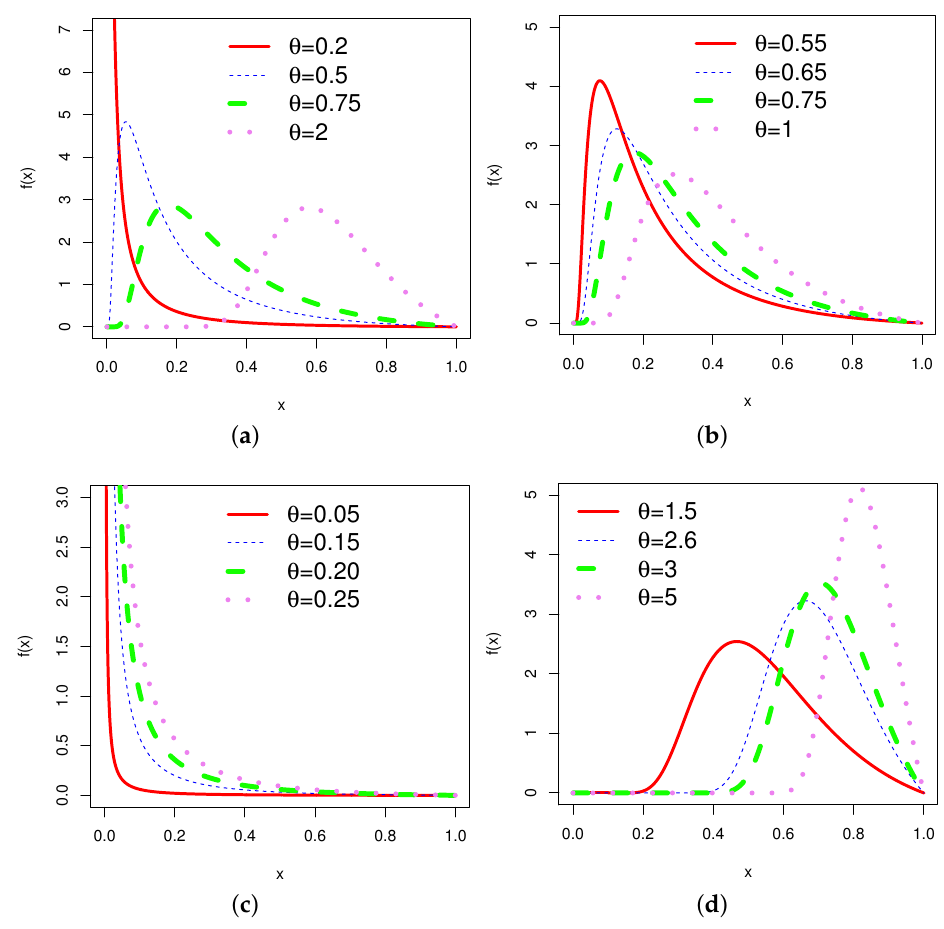
Figure 1. Plots of various shapes of the pdf of the UTD for varying values of the parameter θ .